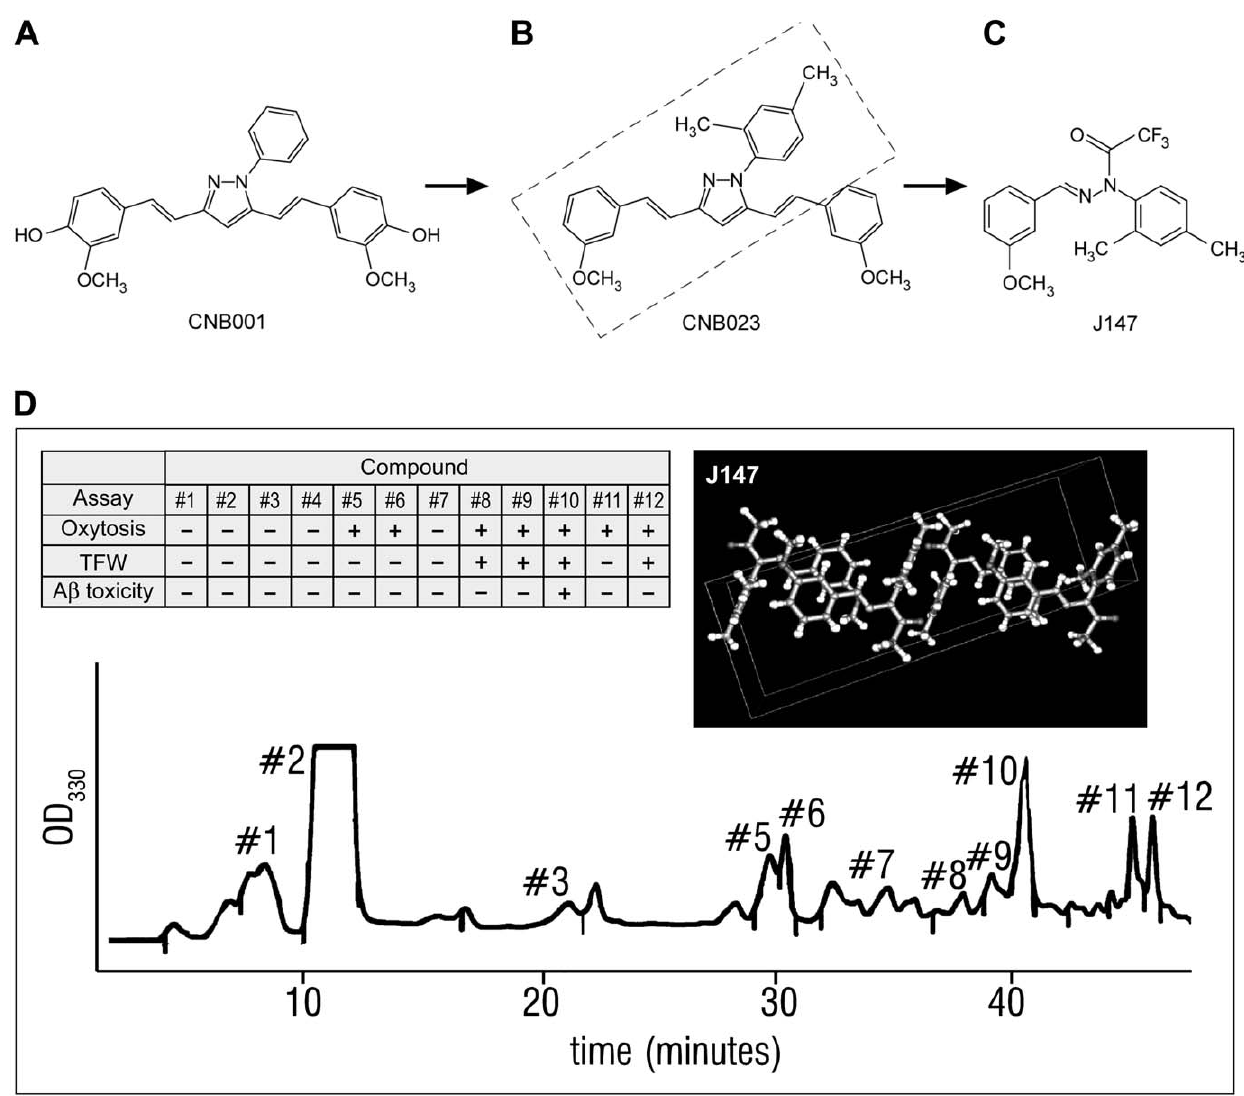
Figure 1. Selection of J147. CNB-001 (A) is a broadly neuroprotective and neurotrophic derivative of curcumin [8]. CNB-023 (B) is a derivative of CNB-001 lacking hydroxyl groups but with similar activity that was identified by SAR analysis of CNB-001. The boxed area shows the hypothesized biologically active fragment of CNB-023. A large collection of molecules around this chemical space was generated by the reaction of m-anisaldehyde with 2.4 dimethylphenyl hydrazine (see Materials and Methods) and J147 (C) was selected from the reaction products on the basis of its activity in trophic factor withdrawal (TFW), oxidative stress (oxytosis) and A b toxicity assays (see Figure 2). (D) Final HPLC run of reaction mixture that generated J147. The structure of the most active product (fraction 10) was determined by NMR. J147 was then synthesized, and its crystal structure (insert) determined, confirming its biological activity and structural identity. The following are de-risking and target identification screens, with no significant reproducible hits. J147 was used at 10 micromolar unless indicated. (1) LeadProfiling + P450 screen. Over 60 CNS receptors and transporters (work done by MDS Pharma). (2) hERG (work done by MDS and Absorption Systems). (3) Acute toxicity in rats. Negative at 2 grams/kilogram (work done by Absorption systems). (4) CeeTox ‘‘Safe’’ up to 90 micromolar plasma concentration (work done by CEETOX, INC). (5) 352 protein kinases (done by Ambit). (6) MDRI-MDCK brain penetration classification ‘‘High’’ (work done by Absorption Systems). (7) Enzyme Assays. Cox 1; Cox 2; Lox 5,12,15; Sirt 1,2,3; LT4 hydrolase; LTC4 synthase; cathepsin B; matrix metalloprotease 1; phosphodiesterases 10A1, 11A1, 1A, 2A, 3A, 4A1A, 4B1, 5A, 6, 7A, 7B,